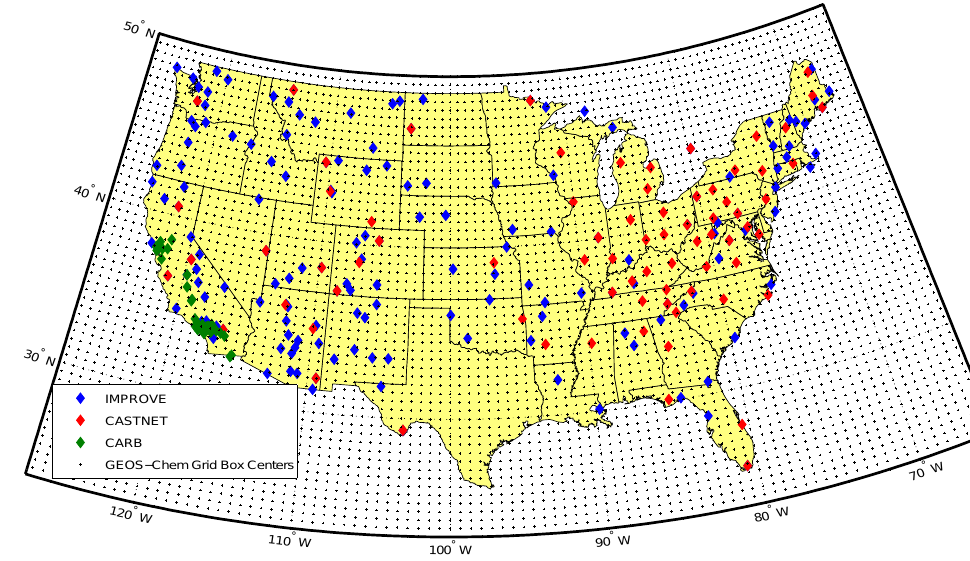
Fig. 1. Locations of IMPROVE, CASTNET, and CARB measurement sites, and GEOS-Chem grid box centers over the